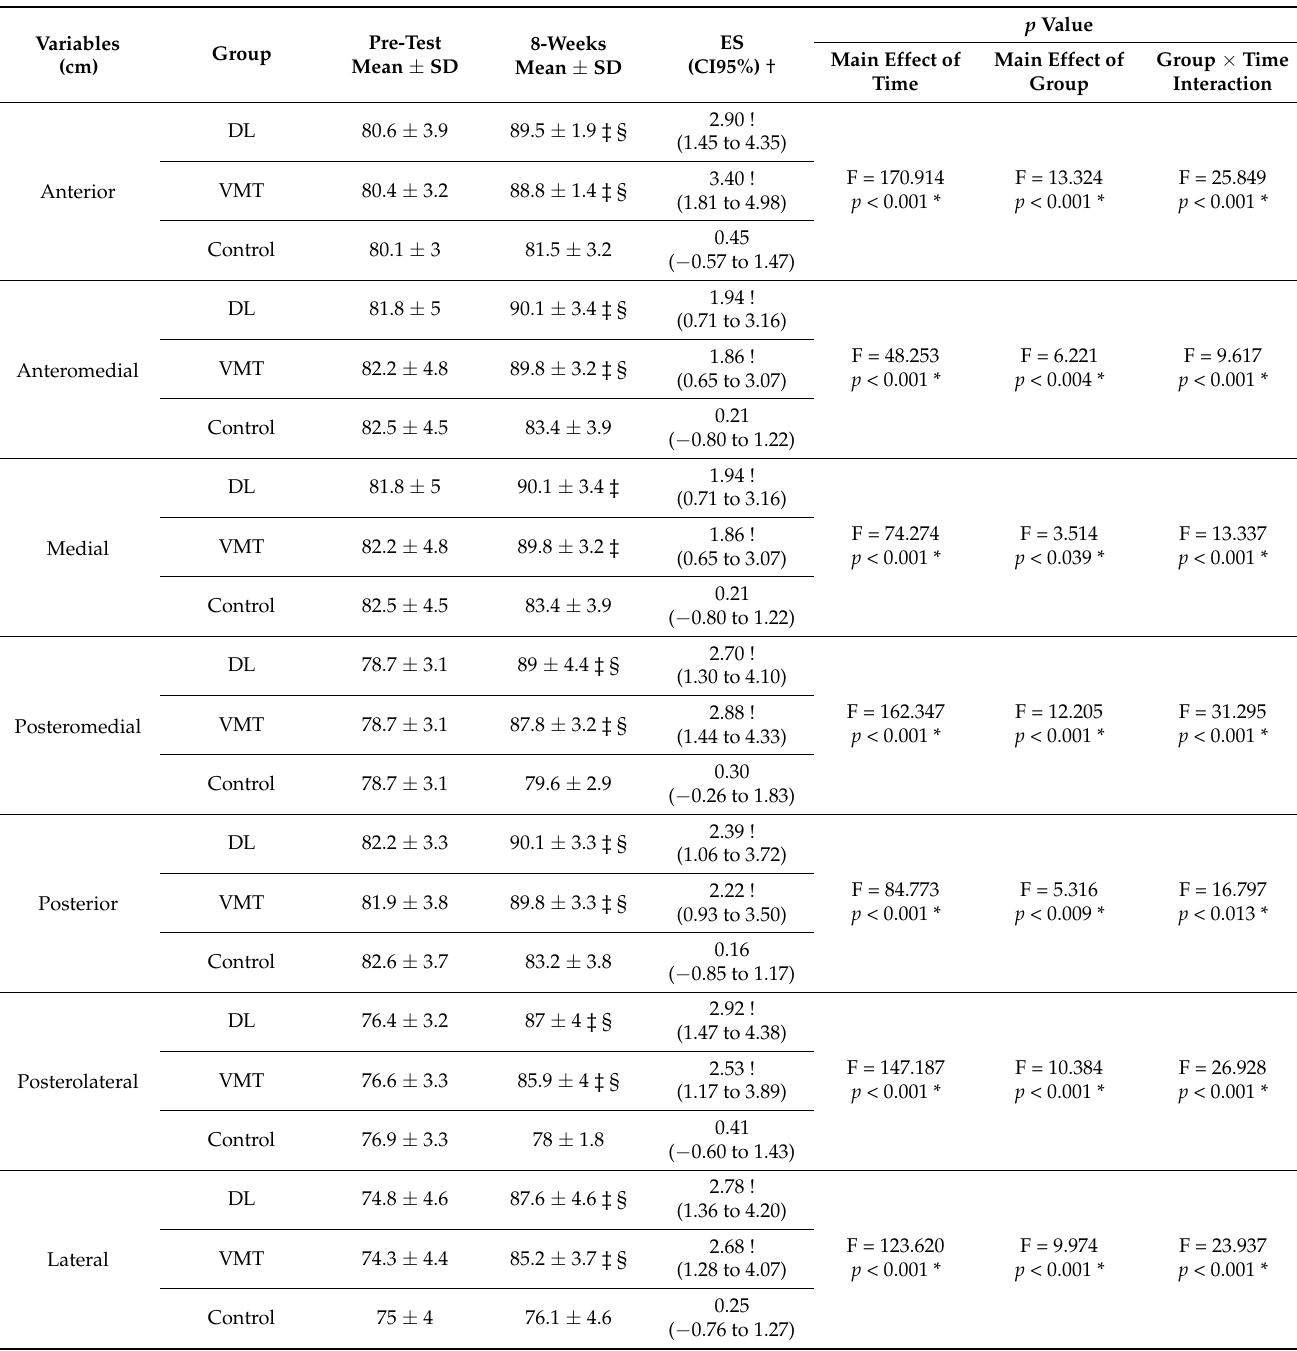
Table 6. Statistical results for between and within-group changes of Star Excursion Balance Test